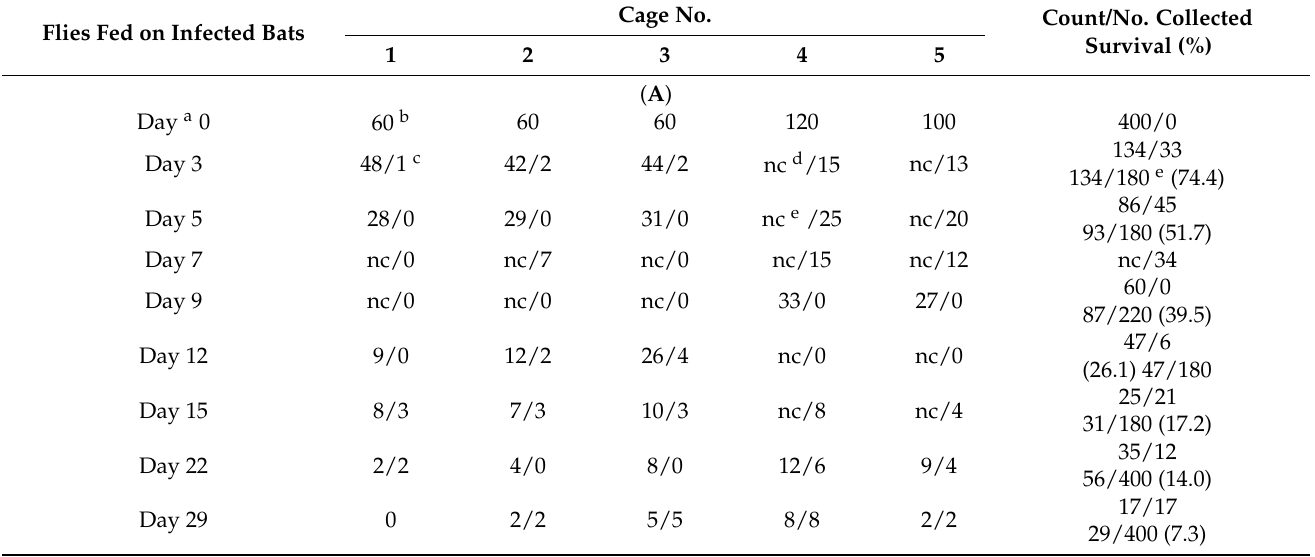
Cage No. Count/No. Collected